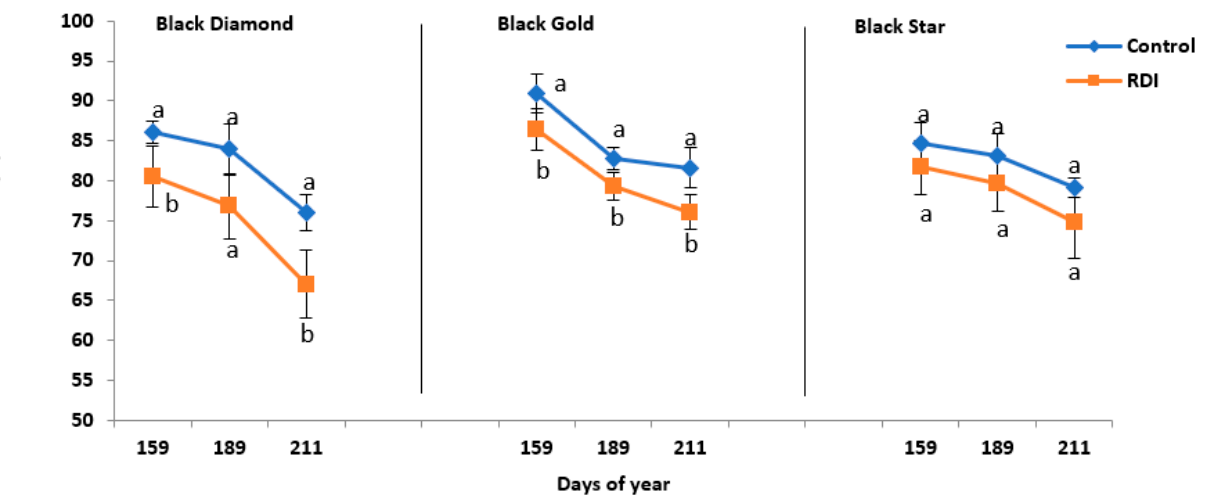
Figure 3. Relative water content (RWC %) of three plums cultivars BD, BG, and BS subject (RDI) or not (CI) to regulated deficit irrigation. Values are the means of twelve samples ( n = 12) ± standard deviation. The letters a and b indicate significant differences ( p ≤ 0.05) between the two irrigation treatments, within the same date.